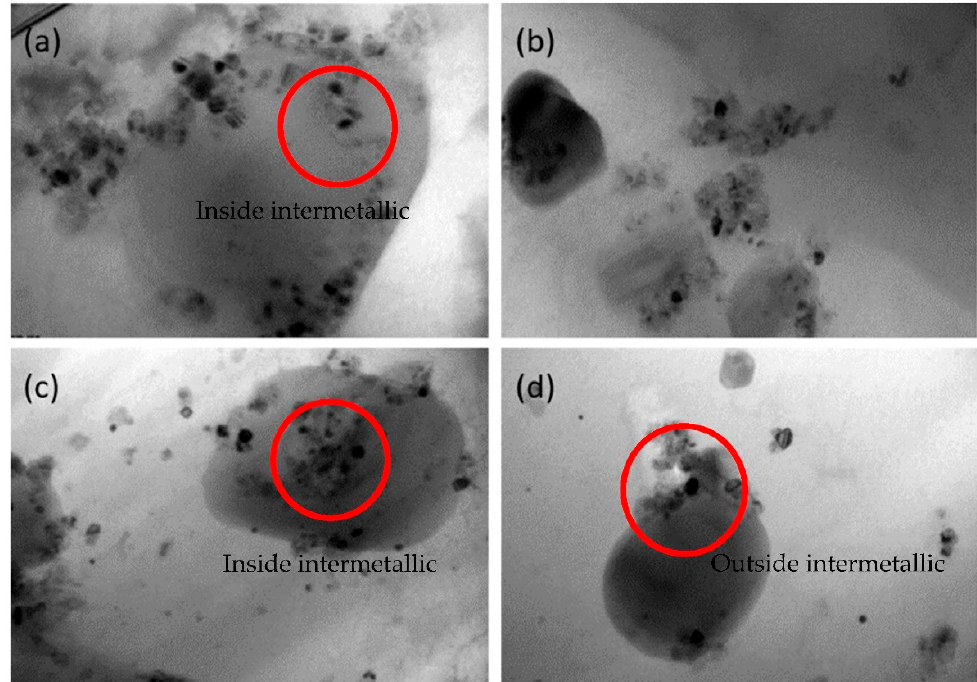
Figure 7. Reinforcement of nanoparticles: ( a , b ) SiC inside intermetallics; ( c ) TiC inside intermetallics; ( d ) TiC around intermetallics [53] .